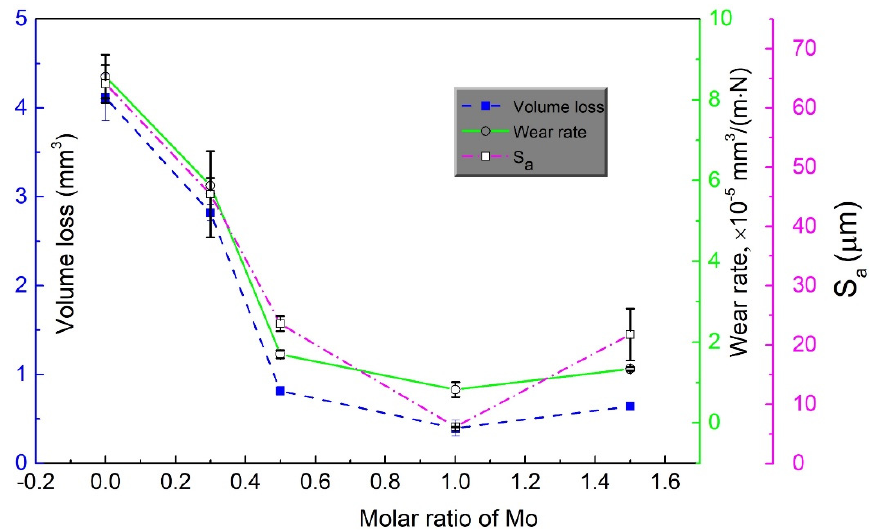
Figure 10. Volume loss, specific wear rates, and the average surface roughness (Sa) of wear scars for Mo x ( x = 0, 0.3, 0.5, 1, 1.5) high entropy